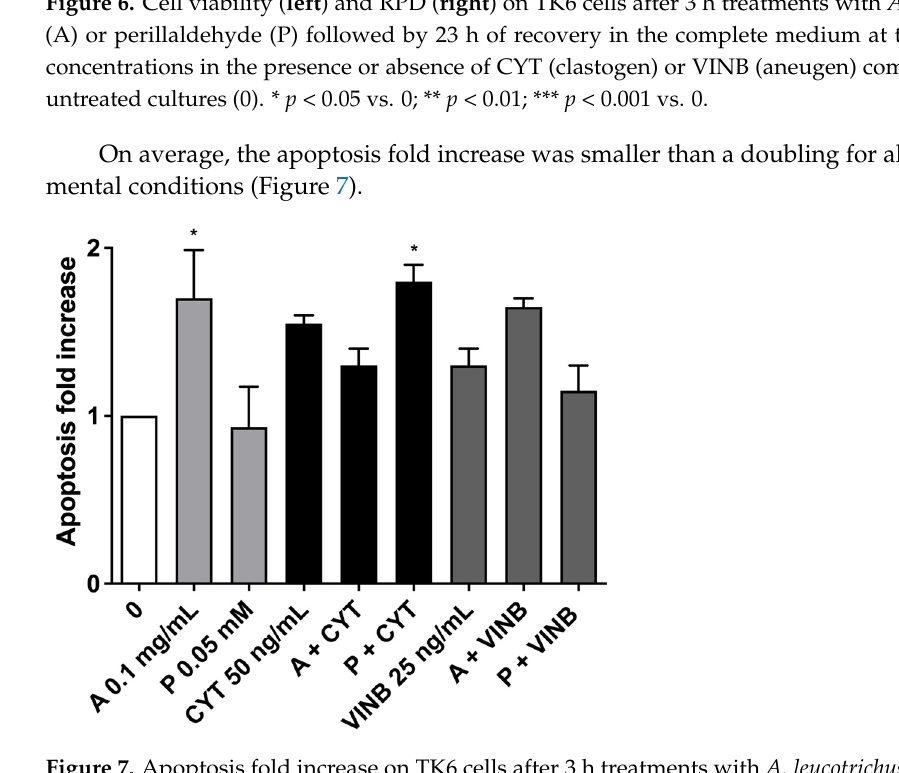
Figure 7. Apoptosis fold increase on TK6 cells after 3 h treatments with A. leucotrichus (A) or perillaldehyde (P) followed by 23 h of recovery in the complete medium at the indicated concentrations in the presence or absence of CYT (clastogen) or VINB (aneugen) compared to the untreated cultures (0). * p < 0.05 vs. 0.